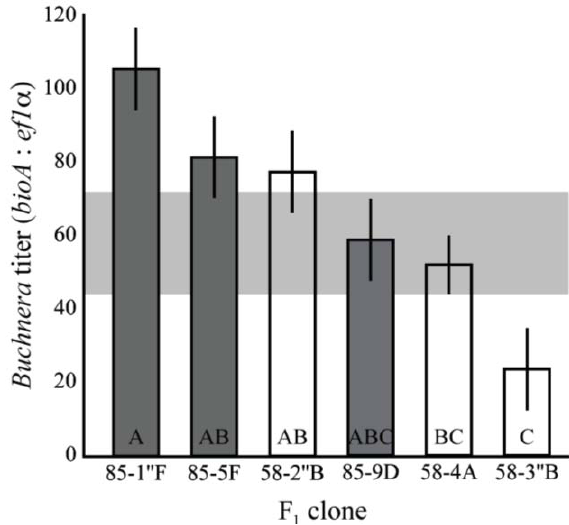
offspring clones from a reciprocal cross of 8-10-1 Figure 3. Symbiont titer in 1 st instar F 1 = 2.9, p = 0.0004, ANCOVA), though there was and 5A. Clones varied significantly (F 6,41 no significant effect of matriline (p = 0.83, t-test). Open bars are 5A matriline, closed bars are 8-10-1 matriline. Matriline indicates same Buchnera genotype. Shaded area represents the range of titer observed in clones originating from field-collected asexual females. Bars with different letters are significantly different (p < 0.05, Tukey’s HSD). Error bars are ±